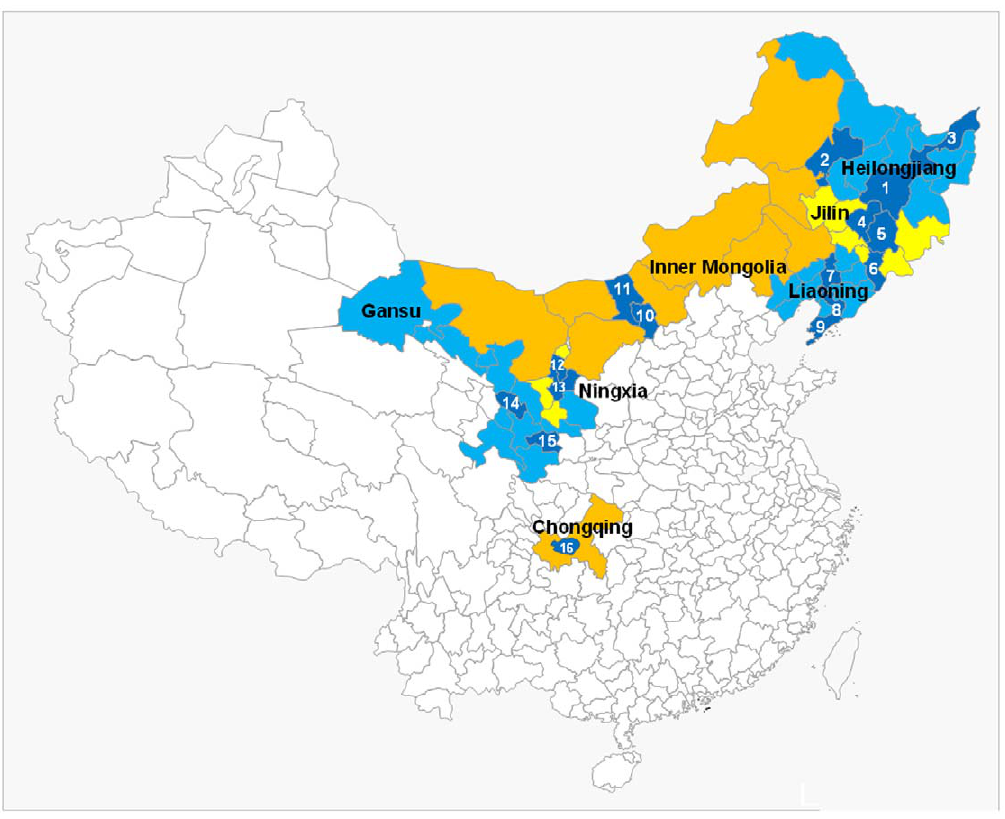
Figure 1. China GF-5 project sites: Location of the 15 cities in 6 provinces and Chongqing Municipality in China. Each number represents a study city.